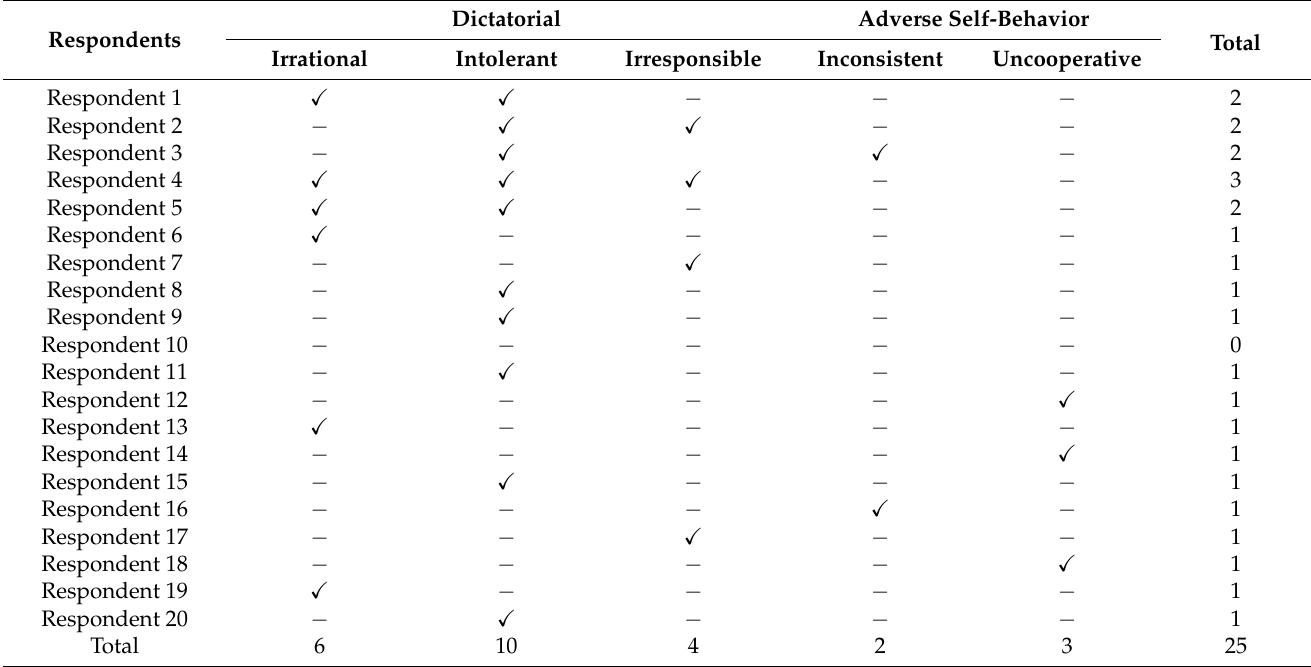
Table 5. Destructive leadership behaviors in BIM-based construction